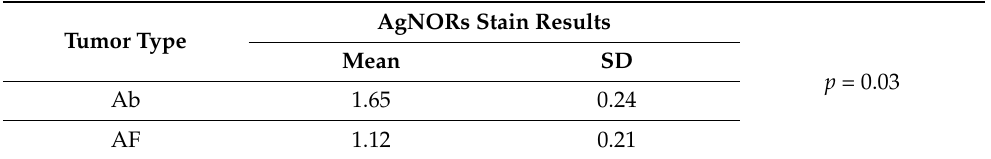
Table 1. Comparison between AgNORs stain results in ameloblastoma versus ameloblastic fibroma. Tumor